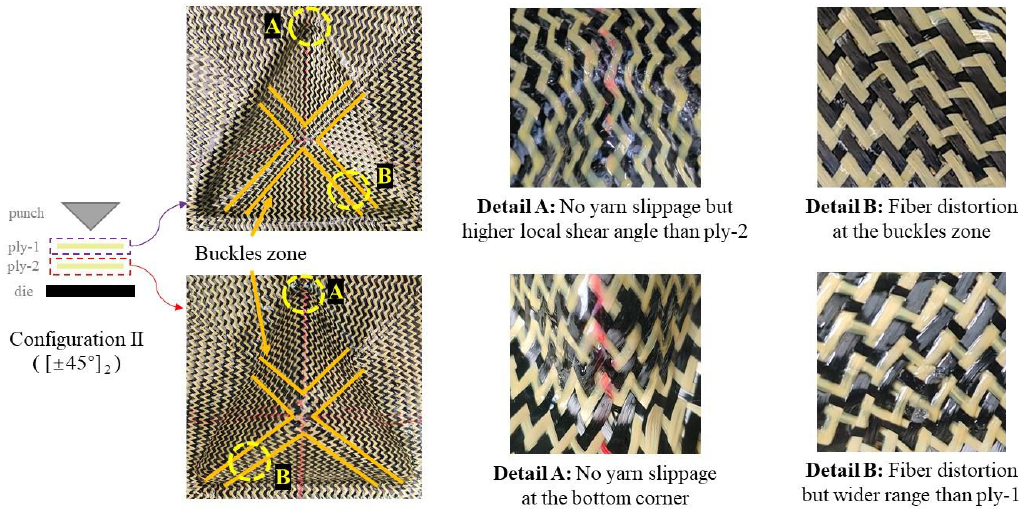
Figure 19. Defects in preform with the consistent orientation between plies. For multi-layer preforms with inconsistent relative orientation between plies, different deformation modes can lead to more serious defects. Figure 20 lists the deformation of each ply in configuration VII. Detail A and detail B correspond to the two bottom corners of the preform, which is the location where yarn slippage along radial direction was easy to occur. It can be seen that under the superposition of multi-layer defects, the deformation of the preform in this place was unsatisfactory, even affecting the useful area. Detail C corresponds to the location where buckling occurs in each ply. Although the buckling positions of adjacent plies were different, they would still affect each other. Under the influence of different deformation modes, the relative slippage between plies was more severe. It can be observed that the yarns were pulled out of the weaving structure at the buckles zone. From the whole preforming results, the location of defects produced by multi-layer preforms was the same as that of single-layer preforms while the range was larger. The factors causing defects were mainly attributed to the inter-ply friction. For the surface with only in-plane shear deformation, the friction is relatively small. The inter-ply friction will not affect the preforming quality, and even better deformation behavior is represented under the action of compaction. However, when out-of-plane deformation occurs, the friction would increase rapidly, which would directly affect the quality of preforms. Fully understanding these friction phenomena is a prerequisite condition for obtaining ideal preforms. Thus, the research on inter-ply friction needs to be further studied.